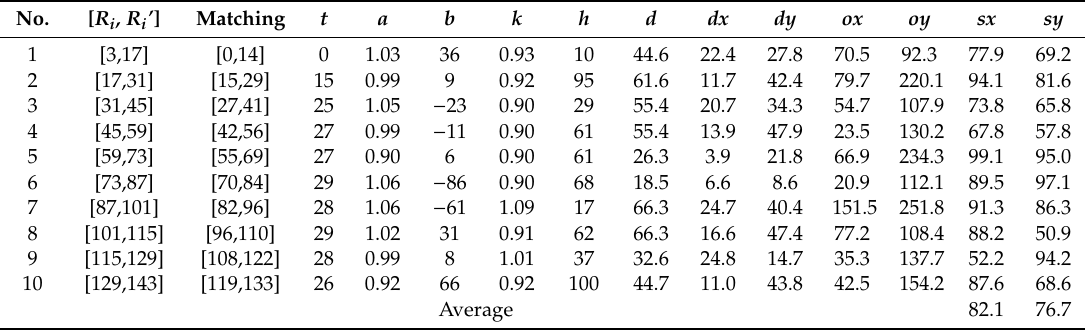
Table 1. Results of segmentation matching between a pair of genuine signature curves ( K = 10). No.